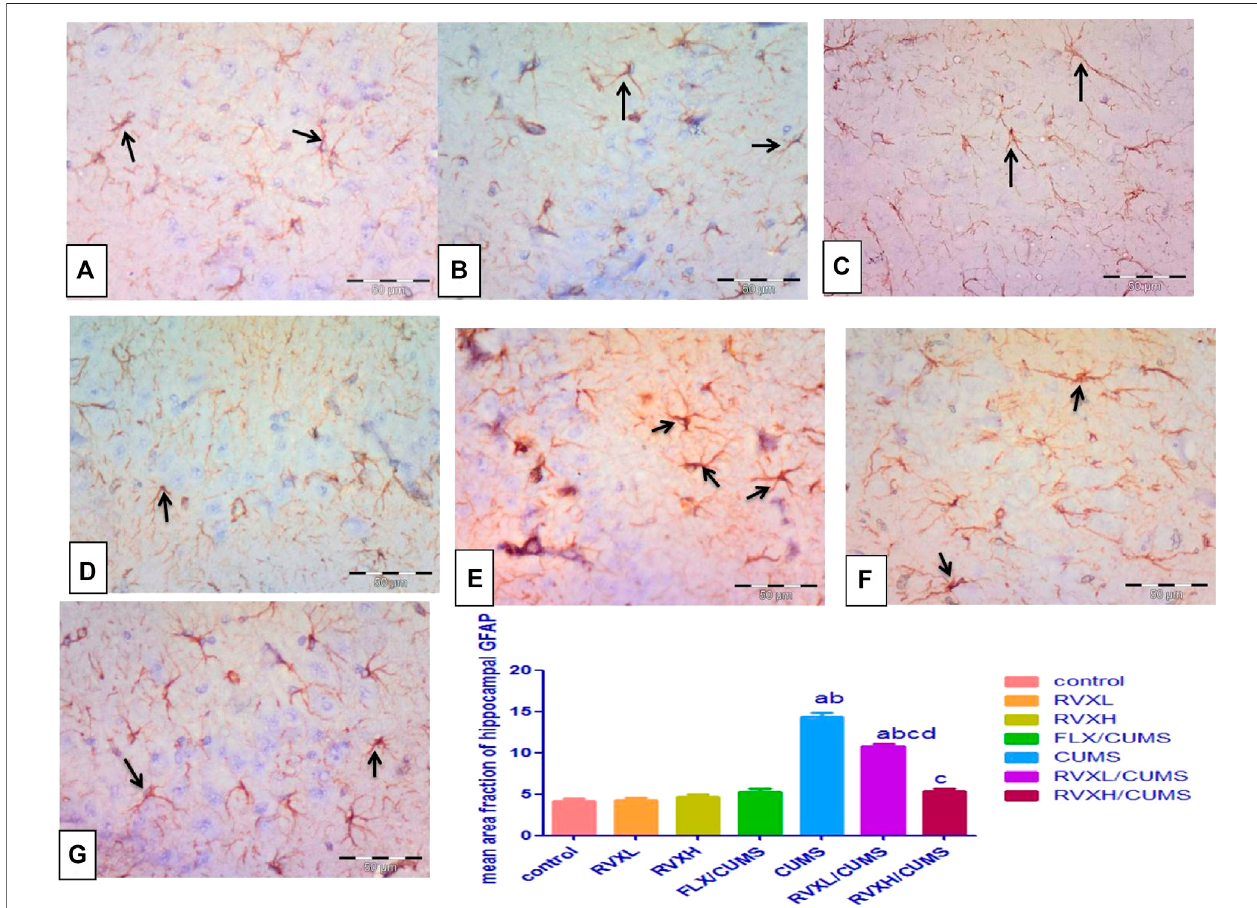
FIGURE6| GFAPimmunoreactivity. (A –– D) Control,RVXL,RVXH,andFLXgroupsshowingsmall-sizedfaintlystainedastrocyteswithfewprocesses(arrows). (E) The CUMS group, displaying enlarged densely stained astrocytes with ramifying processes (arrows). (F) The RVXL/CUMS group, showing less densely stained astrocytes with fewer processes (arrows). (G) The RVXH/CUMS group, displaying more or less normal astrocytes (arrows). GFAP immunostaining x400, scale bars (cid:2) 50 μ m a Signi fi cant difference compared to the control, b signi fi cant difference compared to the FLX group, c signi fi cant difference compared to the CUMS group, and d signi fi cantdifferencecomparedtotheRVXH. p value < 0.0001.CUMS,chronicunpredictablemildstress;FLX, fl uoxetine;RVXL,rivaroxabanlowdose;andRVXH, rivaroxaban